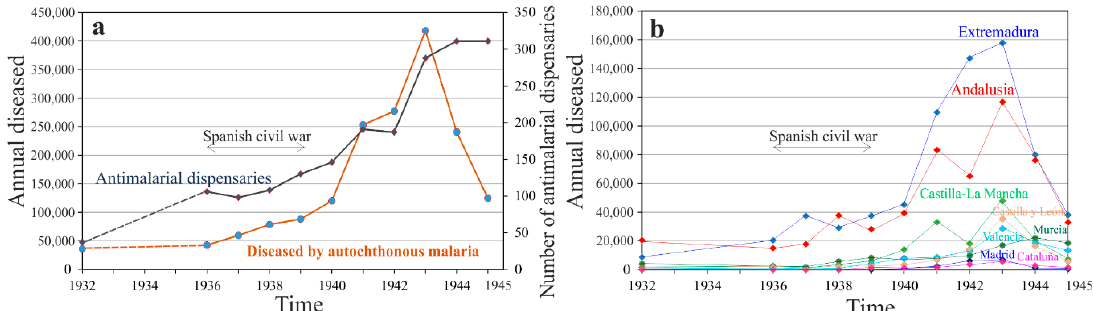
Figure 8. ( a ) Evolution of all antimalarial dispensaries and number of infected people they recorded in Spain from 1932 to 1945. ( b ) Evolution of number of infected people recorded by antimalarial dispensaries from 1932 to 1945 in different regions.